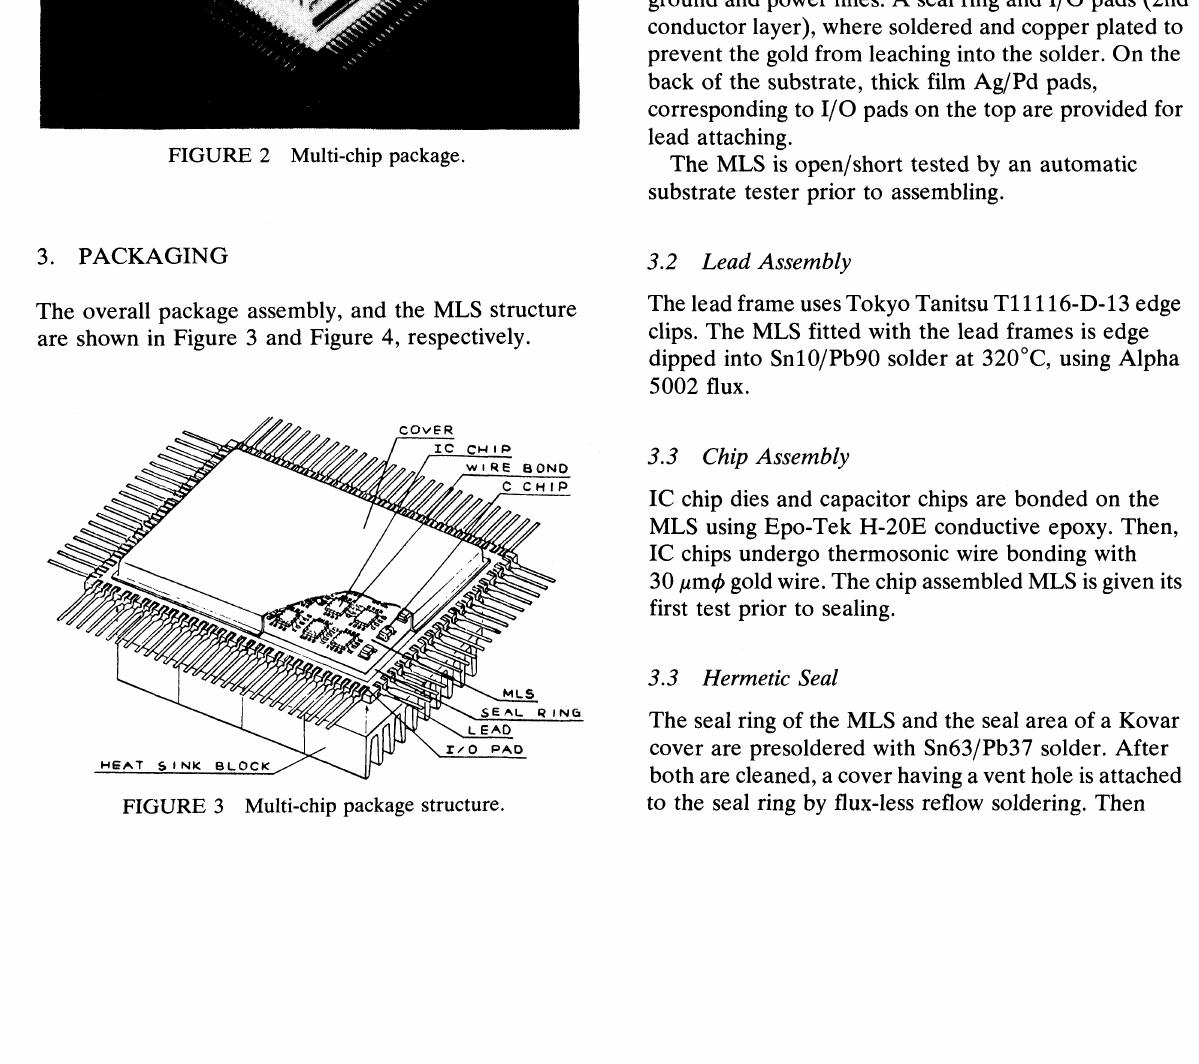
FIGURE MCP vs. DIP-on-PCB per multi-channel counter circuit. FIGURE